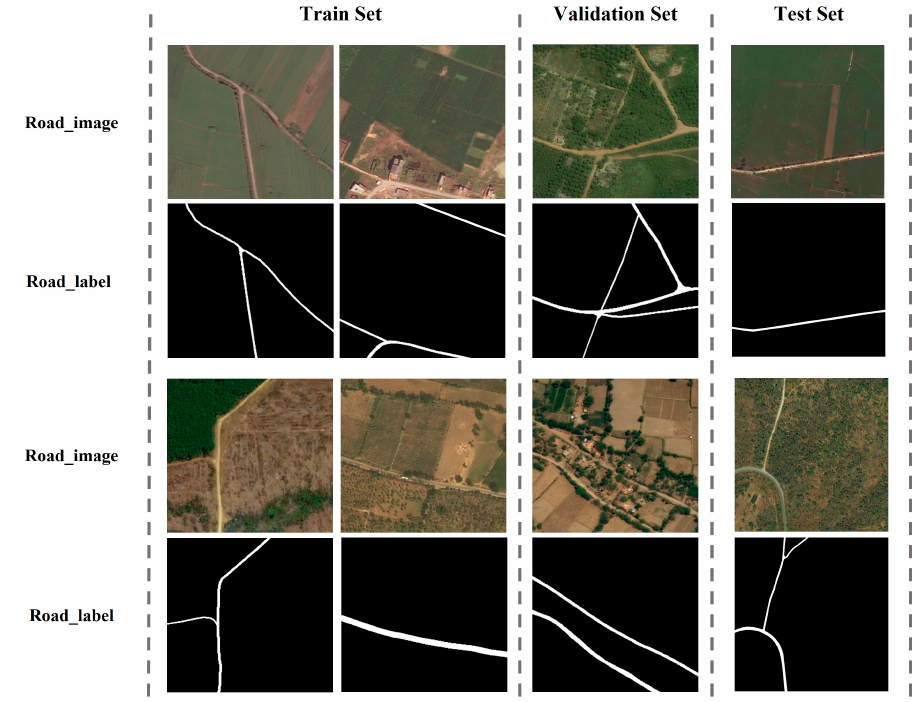
Figure 1. Sample images of the training set, validation set and test set of the rural road dataset.